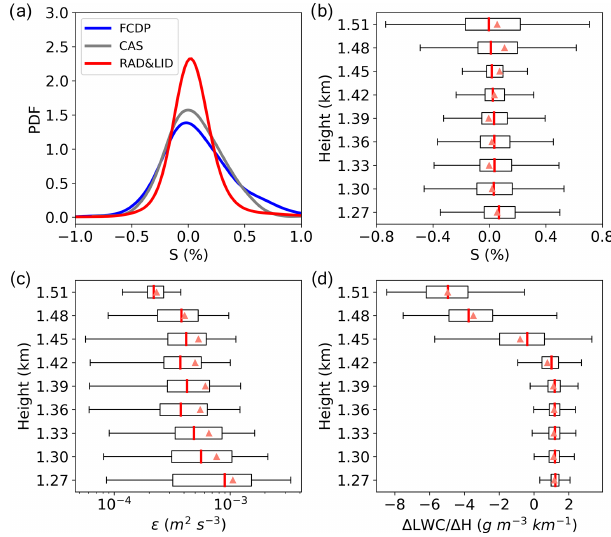
Figure 4. PDF of estimated s and profiles of energy dissipation rate and of the vertical gradients of liquid water content. (a) PDF of es- timated s from the quasi-steady-state assumption (Eq. 2) based on the in situ measurements from the CAS (gray) and FCDP (blue) during the flight leg highlighted in Fig. 2a. PDF of estimated s from remote-sensing measurements (Eq. 11; red) is given for the flight level between 15:00 and 22:00UTC. Box-and-whisker plots are provided for the profiles of (b) s based on Eq. (11), (c) the en- ergy dissipation rate ( (cid:15) ) on a log scale, and (d) liquid water content gradients ( (cid:49) LWC /(cid:49)z ) in the stratocumulus cloud between 15:00 and 22:00UTC. The box and whiskers indicate the 5th, 25th, 50th, 75th, and 95th percentiles, and the means are indicated by